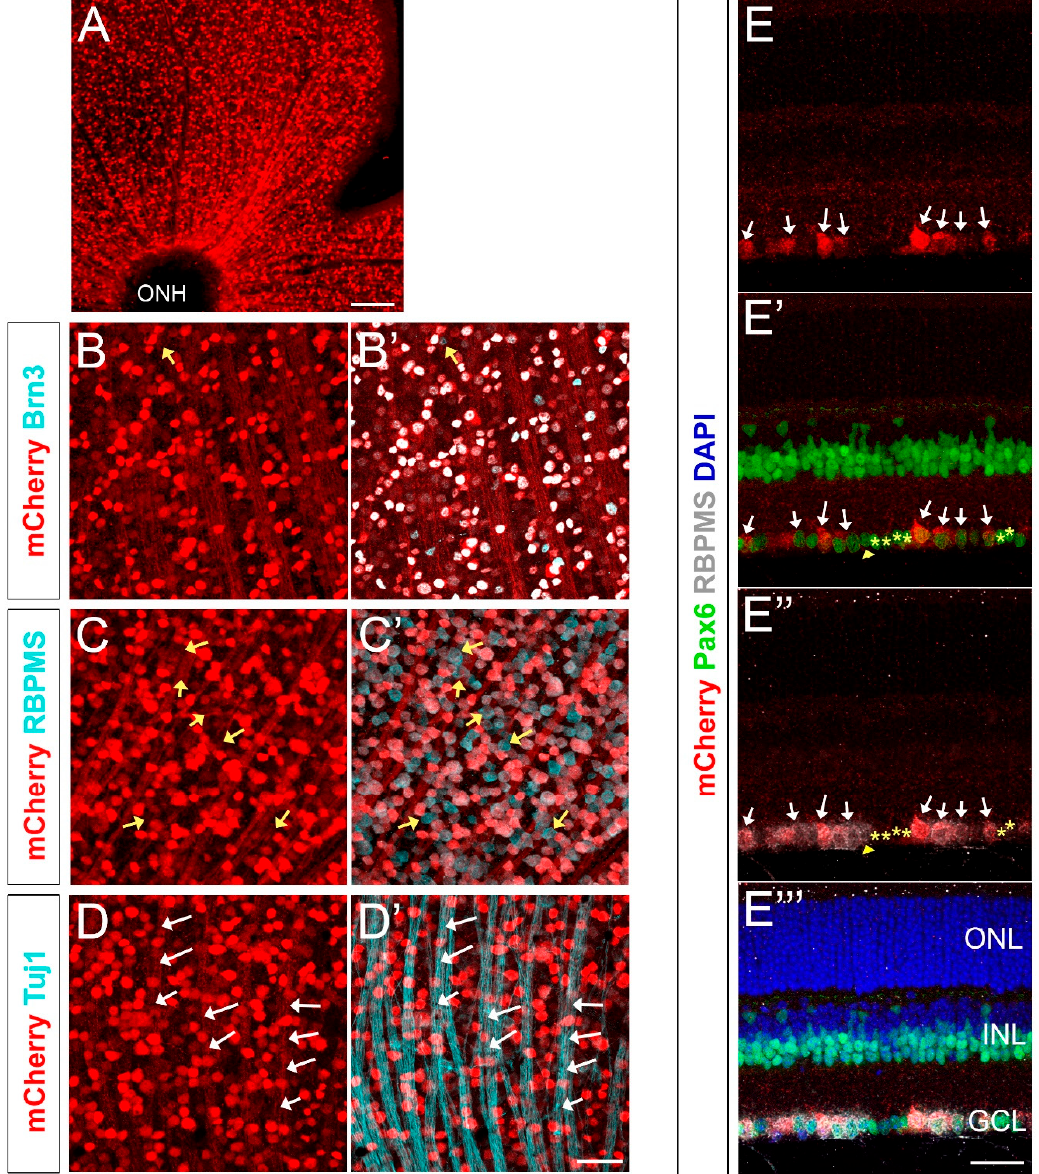
Figure 2. Brn3b-mCherry expression in the adult retina. ( A ) Flat-mounted retina labeled with anti-mCherry antibody. ( B , B’ ) mCherry (red) and Brn3 (teal) colocalization. Yellow arrow indicates a Brn3 + mCherry- cell. ( C , C’ ) mCherry (red) and RBPMS (teal) colocalization. Yellow arrows indicate RBPMS + mCherry- cell bodies. ( D , D’ ) mCherry (red) and Tuj1 (teal) colocalization. White arrows indicate Tuj1 + mCherry + axons. ( E – E”’ ) Cross-section of an adult retina labeled with mCherry (red), RBPMS (gray), DAPI (blue), and Pax6 (green). All mCherry + cells (white arrows) are RBPMS + . Amacrine cells are labeled with yellow stars and are mCherry- (Pax6 + RBPMS − mCherry − cells). Yellow arrowhead corresponds to an mCherry − RGC (RBPMS + Pax6 − mCherry − cell). ONH: Optic Nerve Head. ONL: Outer Nuclear Layer. INL: Inner Nuclear Layer. GCL: Ganglion Cell Layer. Scale bars: 300 microns in A, 50 microns in